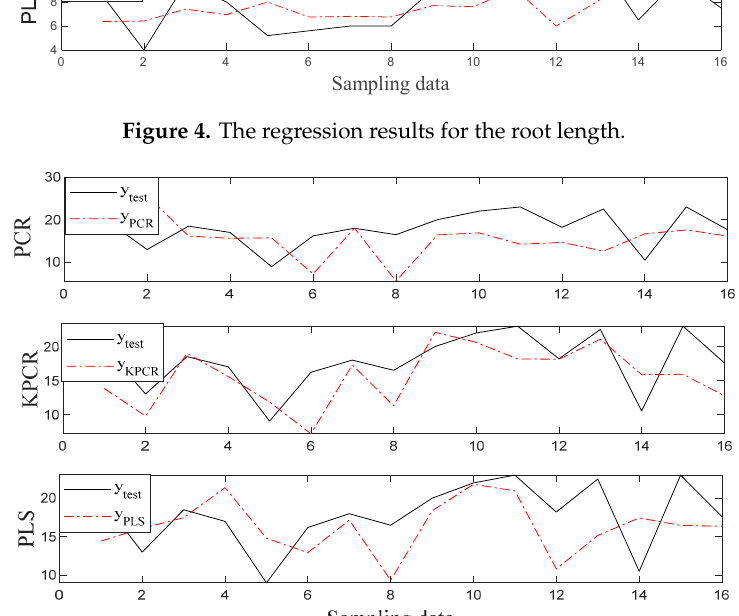
Figure 5. The regression results for the seedling length.